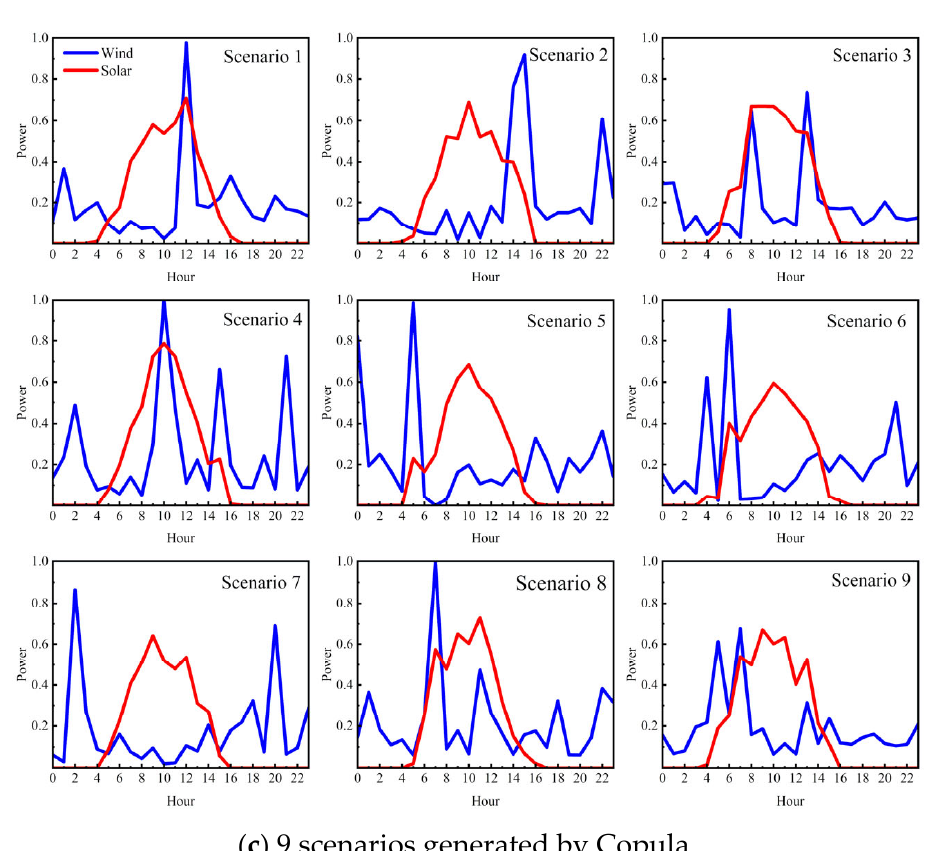
( c ) 9 scenarios generated by Copula Figure 10. Generated scenarios by three methods in Region 4. Figure 10. Generated scenarios by three methods in Region 4. Table 5. The error of the generated The root mean square error (RMSE) and mean absolute error (MAE) of the generated most probable output data are calculated to test the results of scenario generation, as shown in Table 5. Table 6 shows the hybrid system’s RMSE and MAE composed of the generated wind and solar data. (cid:1842) , (cid:1842) represents the photovoltaic output and wind (cid:3046)(cid:3037) (cid:3050)(cid:3037) denotes the total output after the combina- power output in each region, respectively. (cid:1842) (cid:3037) tion in each region. ∆ represents the error di ff erence between the proposed method and Copula, MC. Table 5. The error of the generated data.